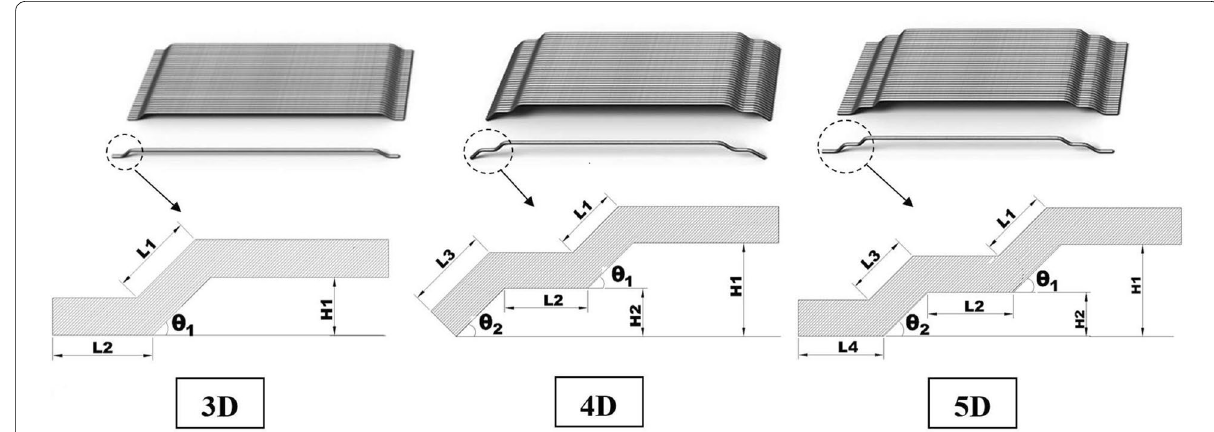
Fig. 1 Geometrical properties of hooked end steel fibres.